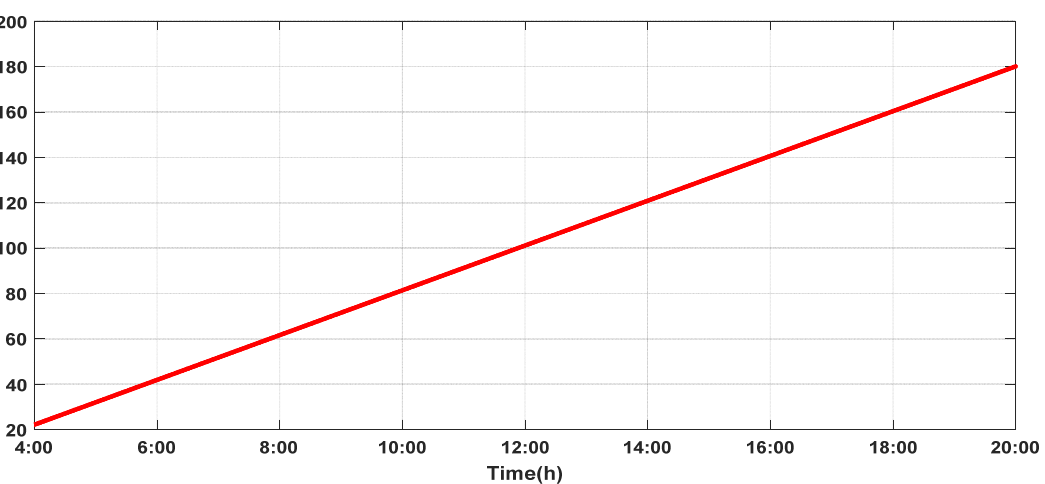
Figure 12. Temporal variation of the sun angle during a day.